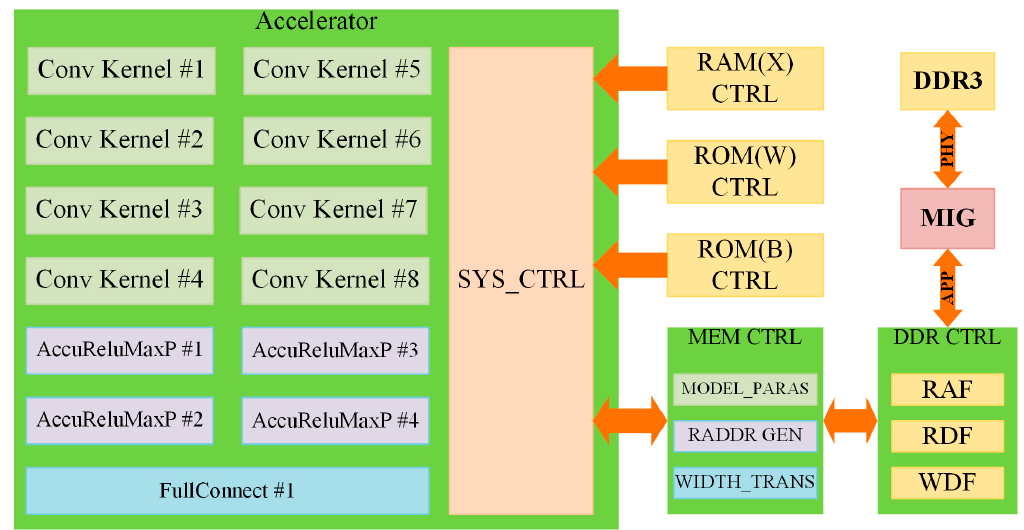
Figure 5. CNN accelerator system architecture includes 3 types of computation module, system controller (SYS_CTRL), memory controller (MEM_CTRL), and Double-Data-Rate SDRAM controller (DDR_CTRL). The red arrows mean the direction of data flow.